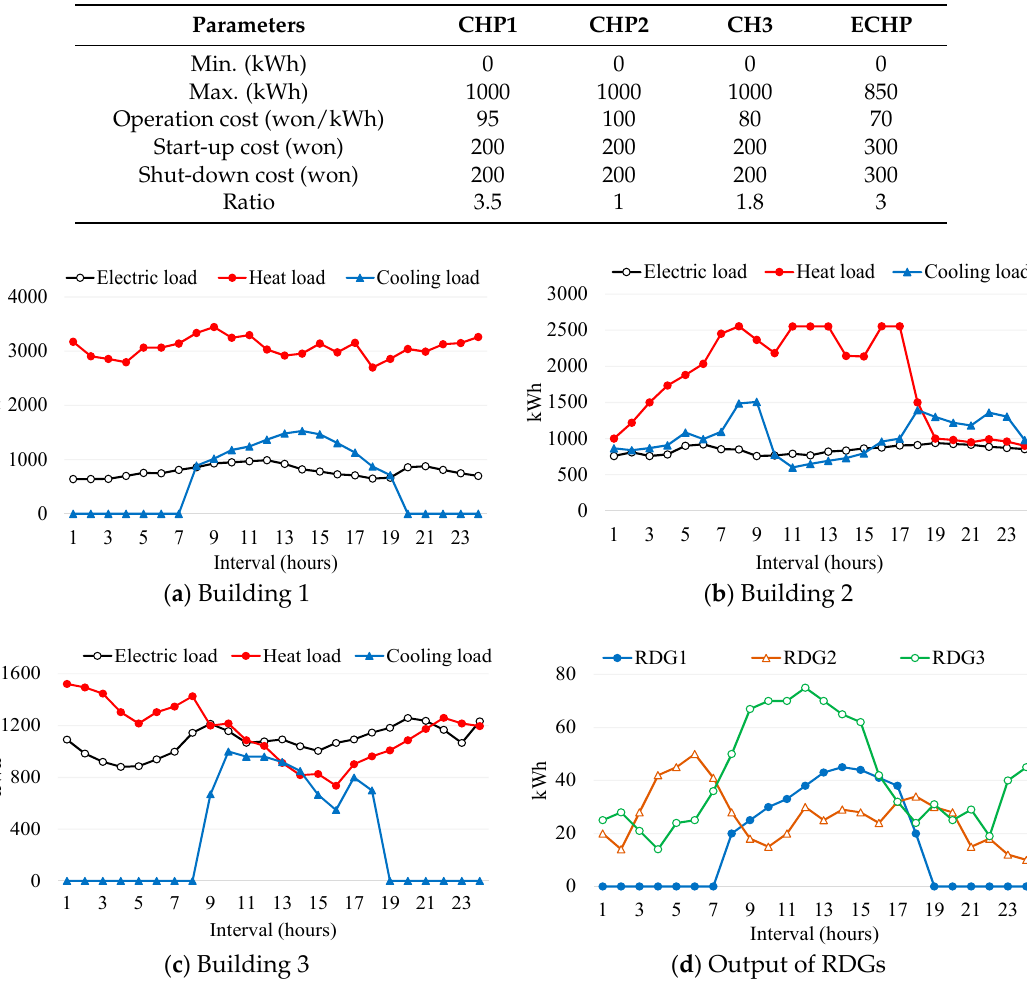
( d ) Output of RDGs Figure 6. Load profiles and output power of RDG in each building during a weekend day.